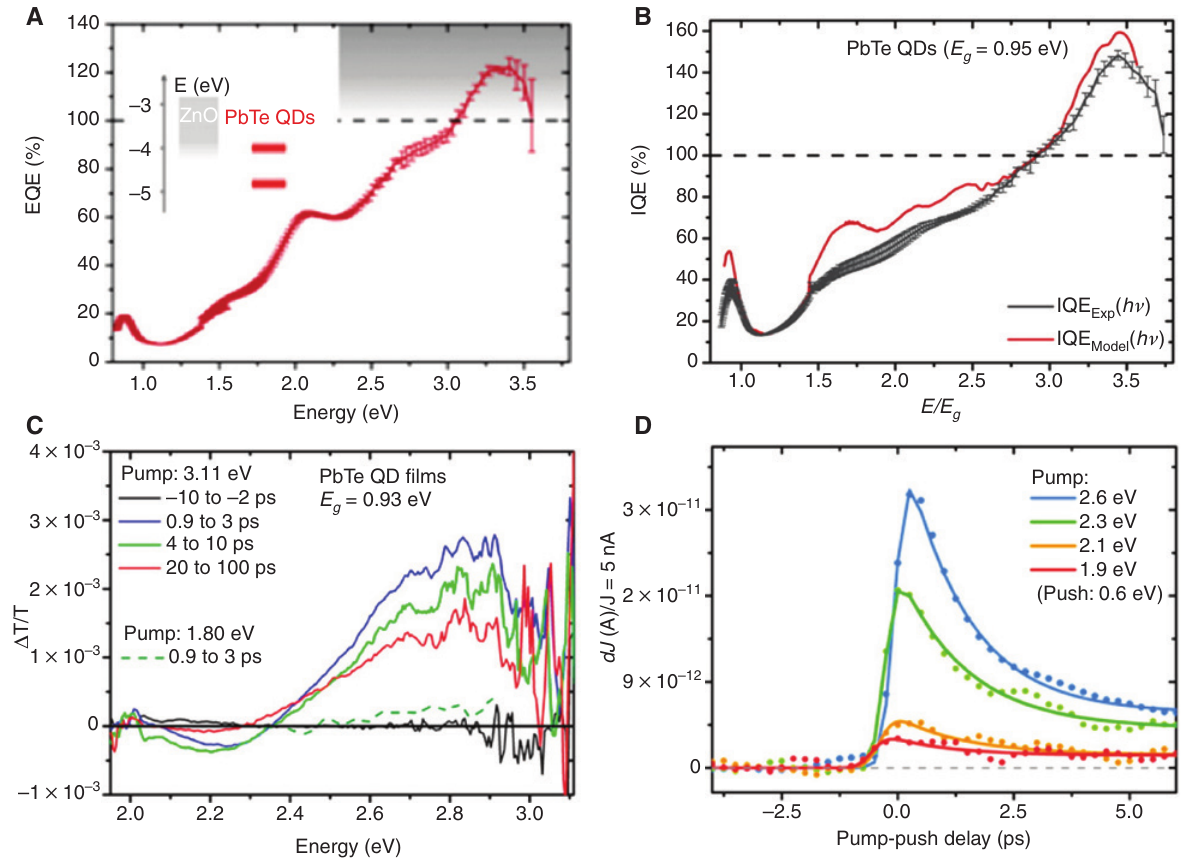
Figure 6: Evidence for carrier multiplication in PbTe quantum dot-containing solar cells. (A) External and (B) internal quantum efficiencies of PbTe QD-based solar cells. The device architecture is sketched in the inset of (A). IQE ( h ν ) and IQE ( h ν ) are the internal quantum efficiencies determined via reflectance measurements and via transfer matrix model- Exp Model ling, respectively. (C) Pump-probe transient absorption experiment conducted on films of PbTe QDs suggesting a transiently stable carrier population at about 2.8 eV. (D) Photocurrent response as a function of time delay between excitation pulse and subsequent low-energy push pulse, which re-energises the initial carrier population. All parts of the figure have been taken from